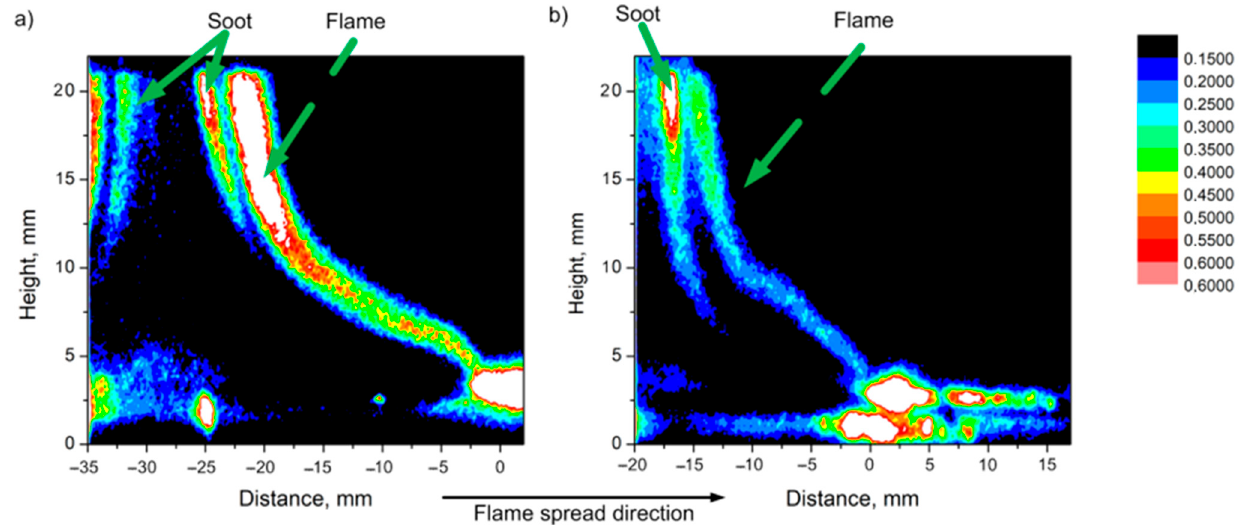
Figure 12. PLIF images (intensity corresponds to the concentration of OH radicals) of ( a ) PMMA flame and ( b ) PMMA + 10% TPP flame during horizontal flame propagation.